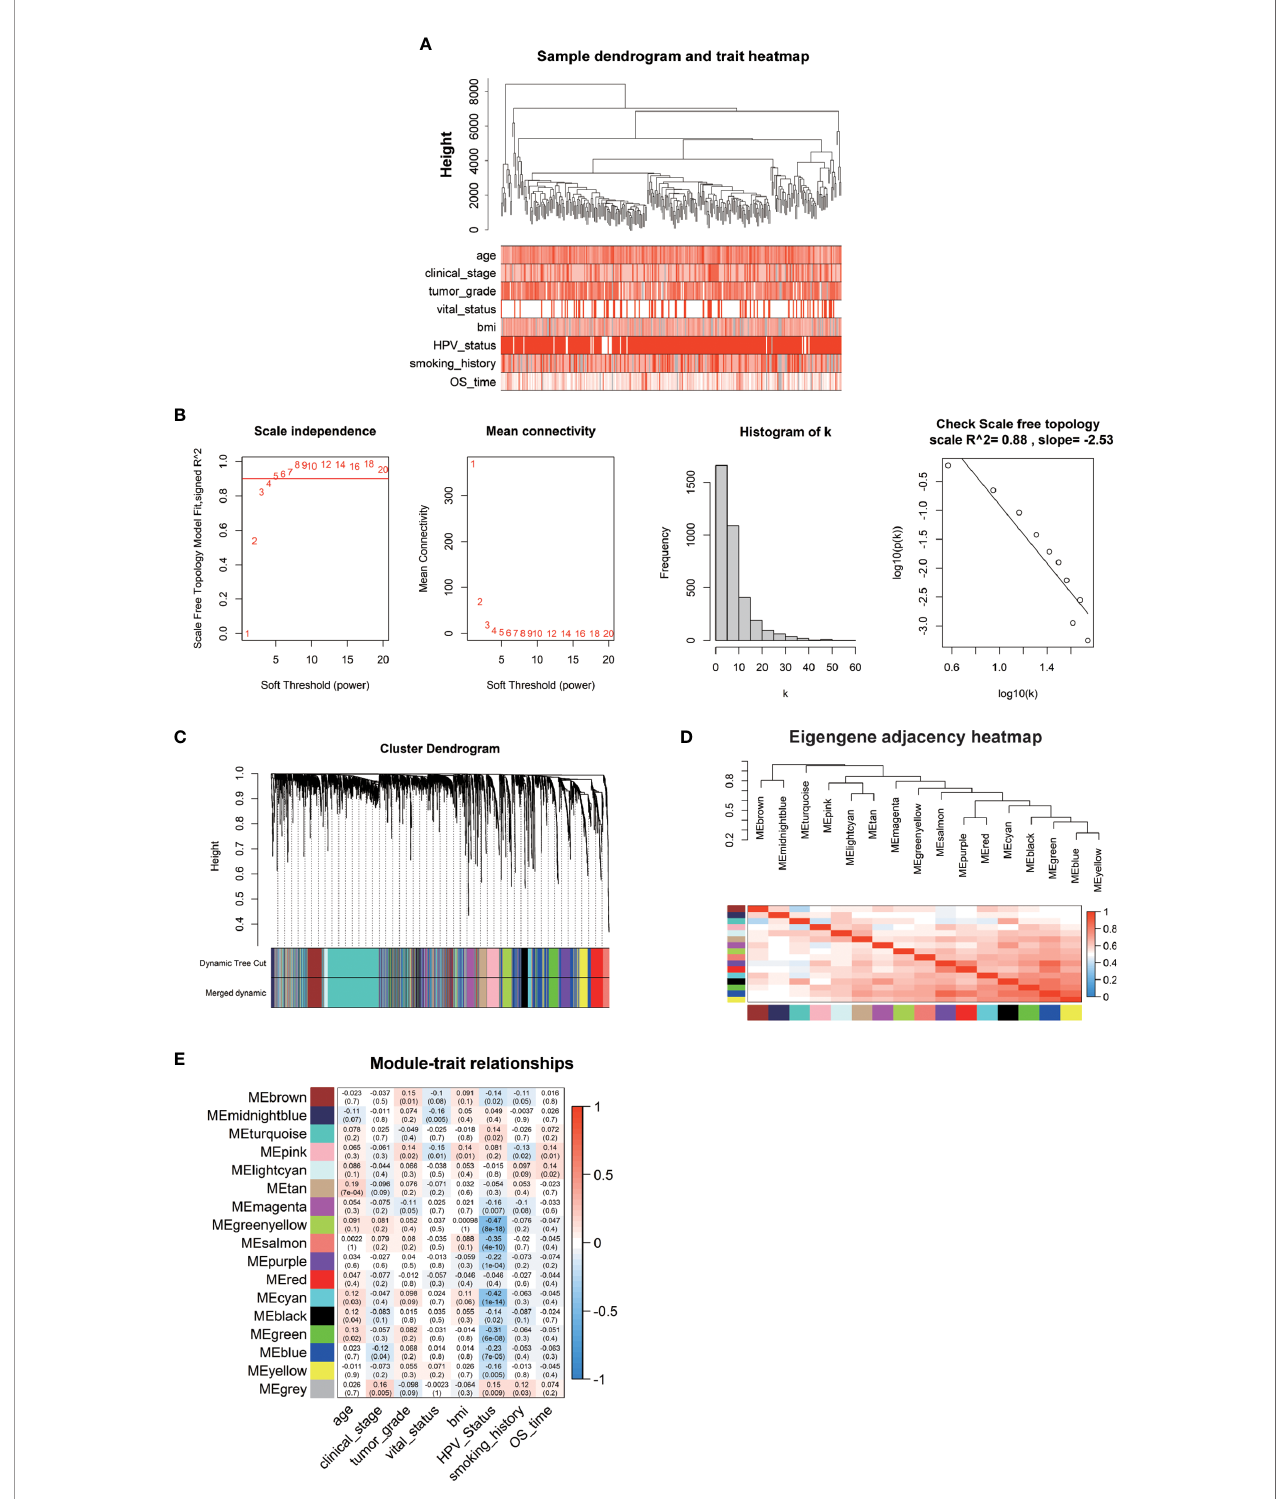
FIGURE 2 | (A) The clinical trait heatmap and tree dendrogram. (B) Determination of soft-threshold power in the WGCNA. (C) Clustering dendrogram of DEGs with assigned module colors. (D) Visualization of gene network using heatmap plot. (E) Heatmap of the correlation between module eigengenes and phenotype of